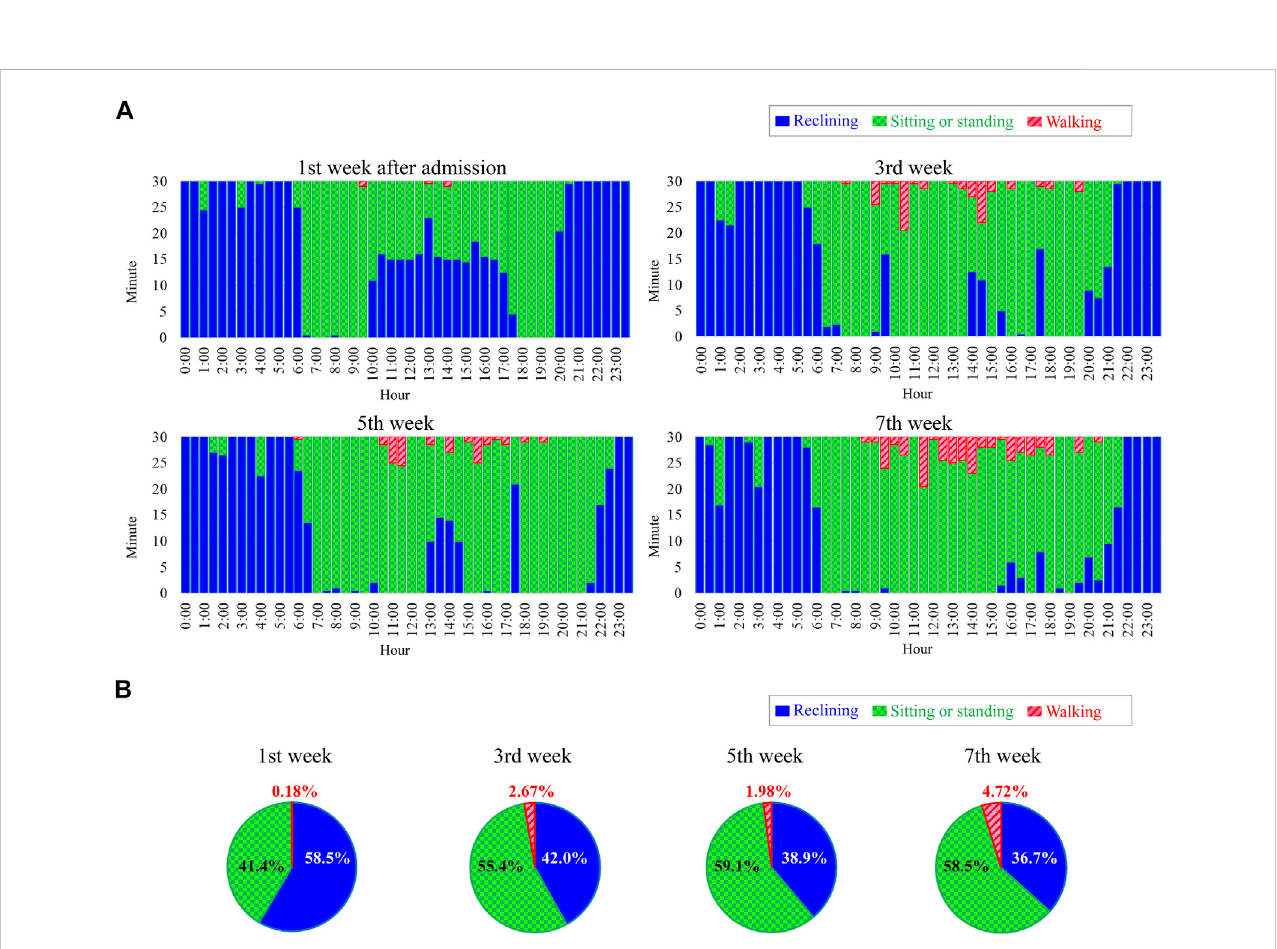
FIGURE 6 Exampleofposturesofastrokepatientduring24 h. (A) Ensembleaveragedposturesfrom1stweekto7thweekafteradmission. (B) Ratiosoftotalperiods of each posture during 24